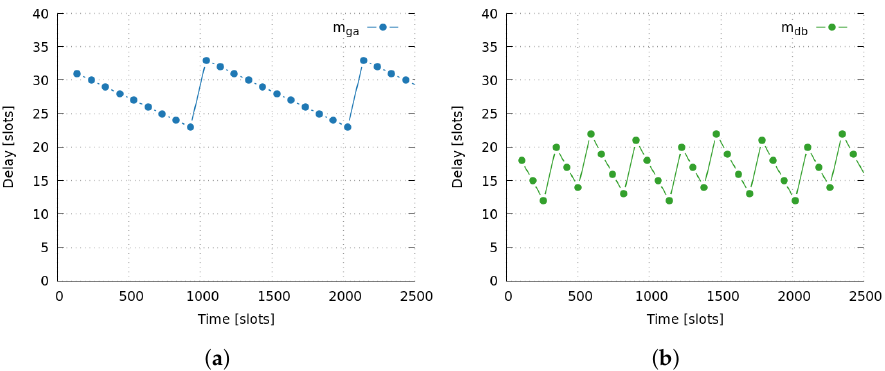
Figure 5. Example of end-to-end delays over time. ( a ) Messages from node g to node a ; ( b ) Messages from node d to node b .